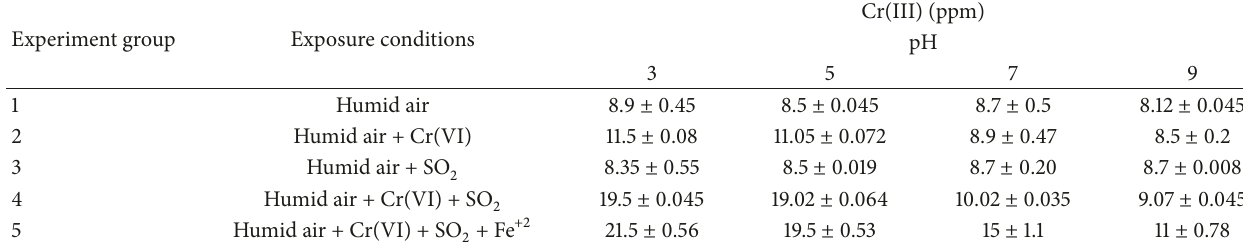
Table 2: Deposition of Cr(III) as a result of coupled Cr(VI) transformation. Experiment group